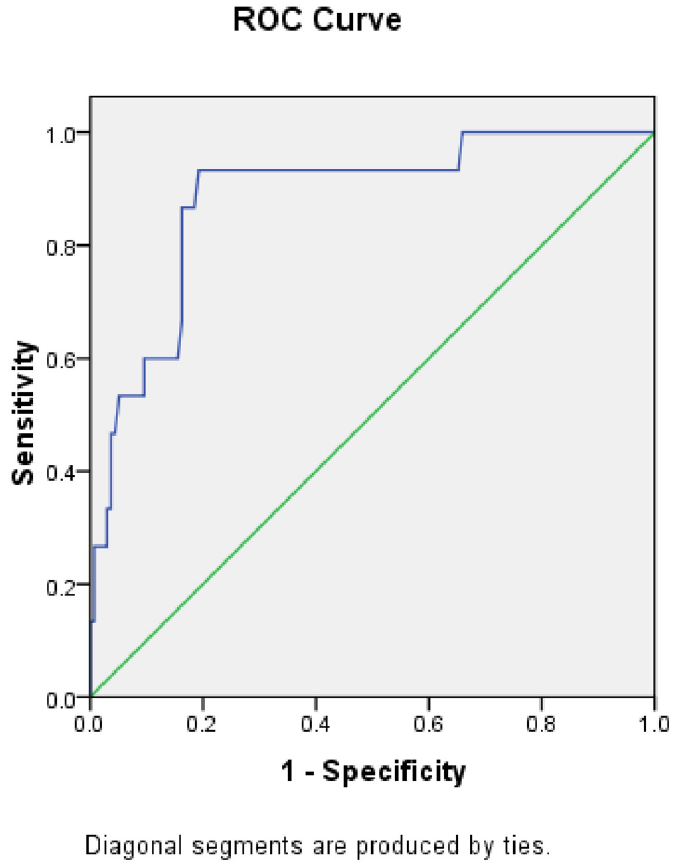
Fig 3. ROC curve for steatosis using a cutoff of 276